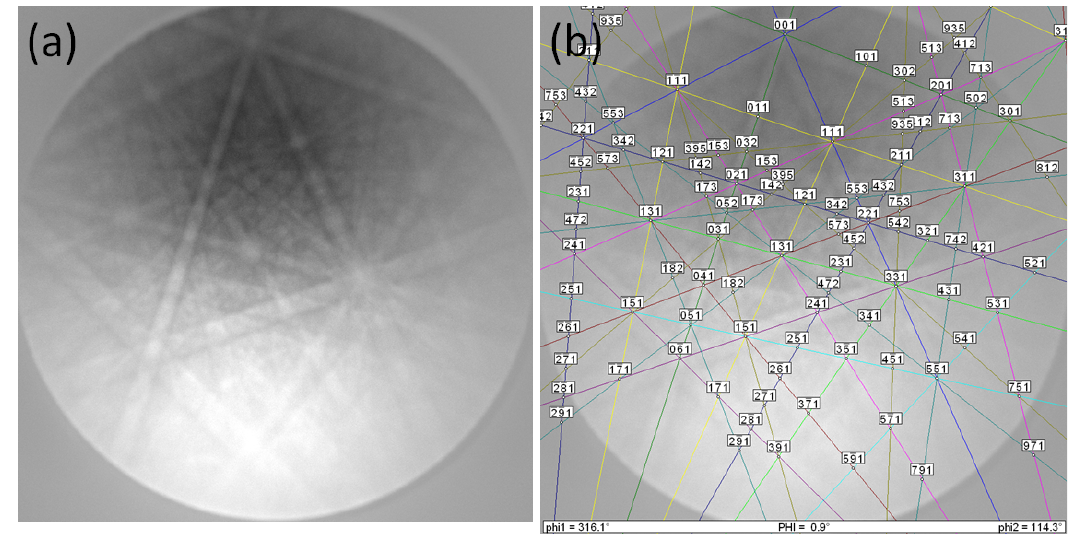
6000, CI = 1).The 6000, CI = 1). ∼ ∼